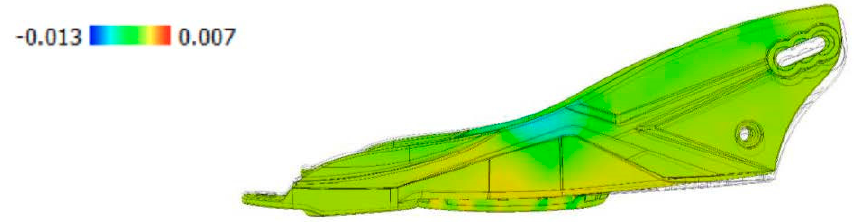
Figure 4. Finite element method (FEM) simulation in dorsiflexion (horizontal axis